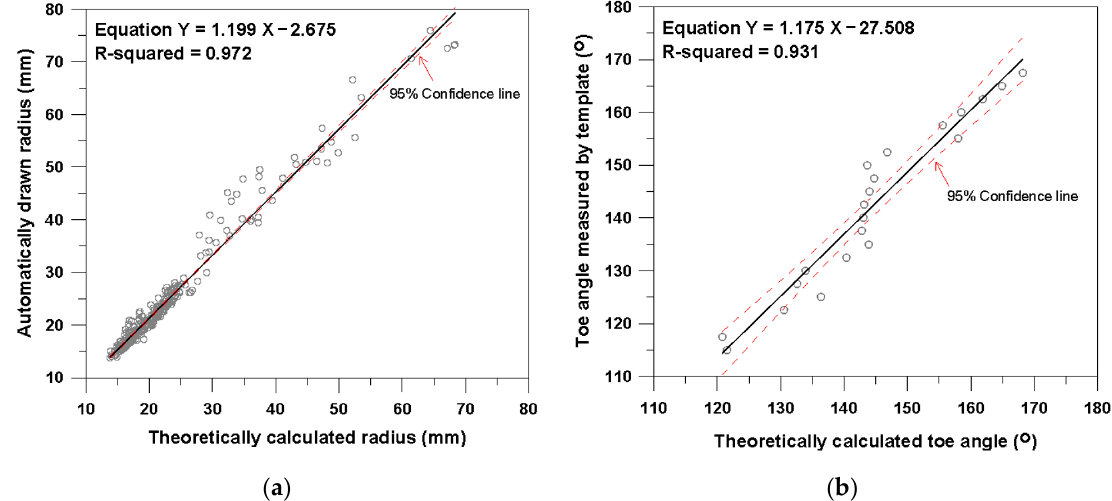
Figure 28. Regression analysis results for the radius and toe angle of the weld bead: ( a ) radius; ( b ) toe angle. ( b ) toe